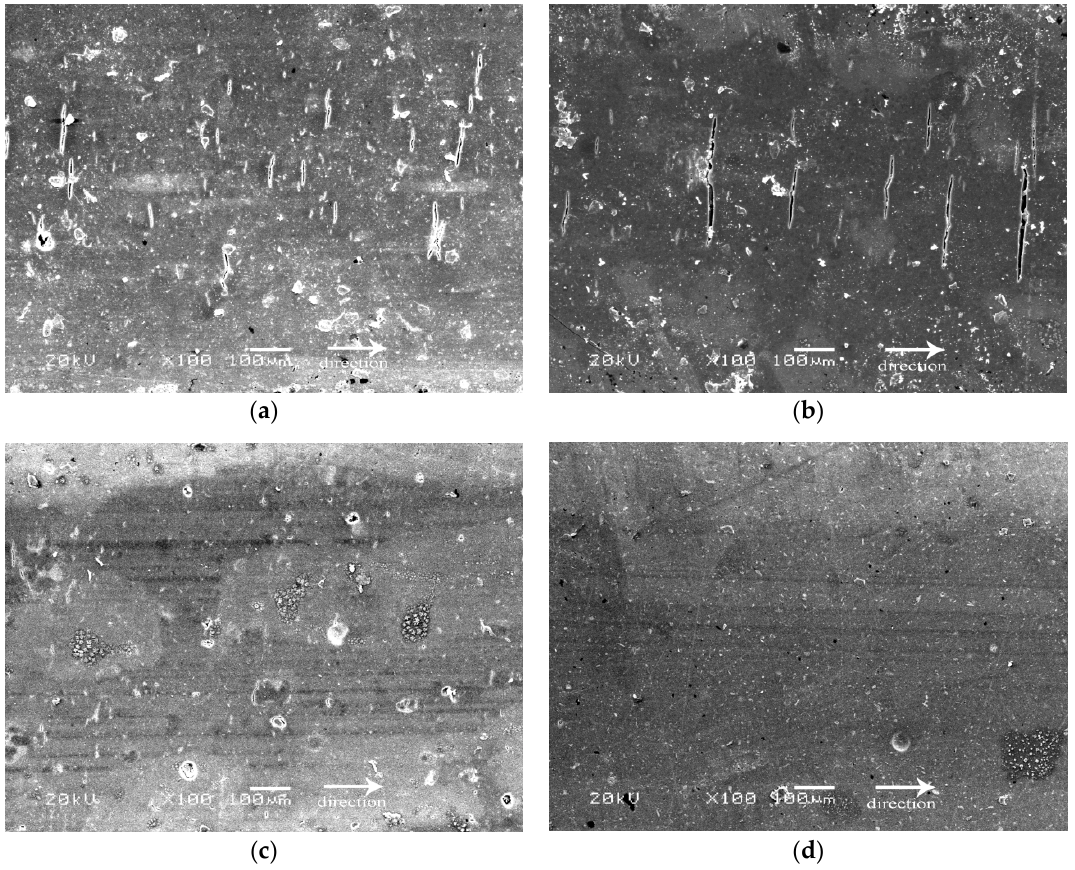
Figure 11. FESEM images of worn surfaces composite ( a ) EP, ( b ) EP + 6%MoS 2 , ( c ) EP + 4%H-CNTs, ( d ) EP + 6% MoS 2 + 4%H-CNTs.